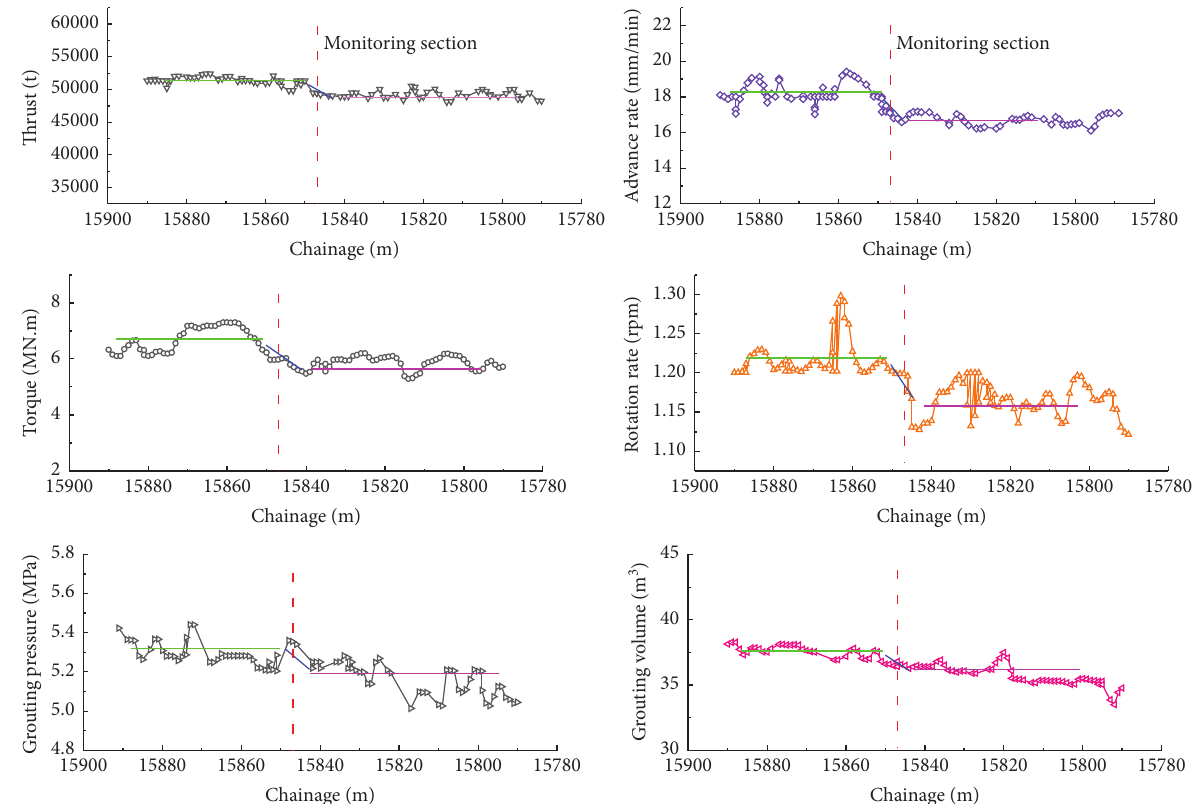
Figure 13: Adjustment of tunnelling parameters during the construction